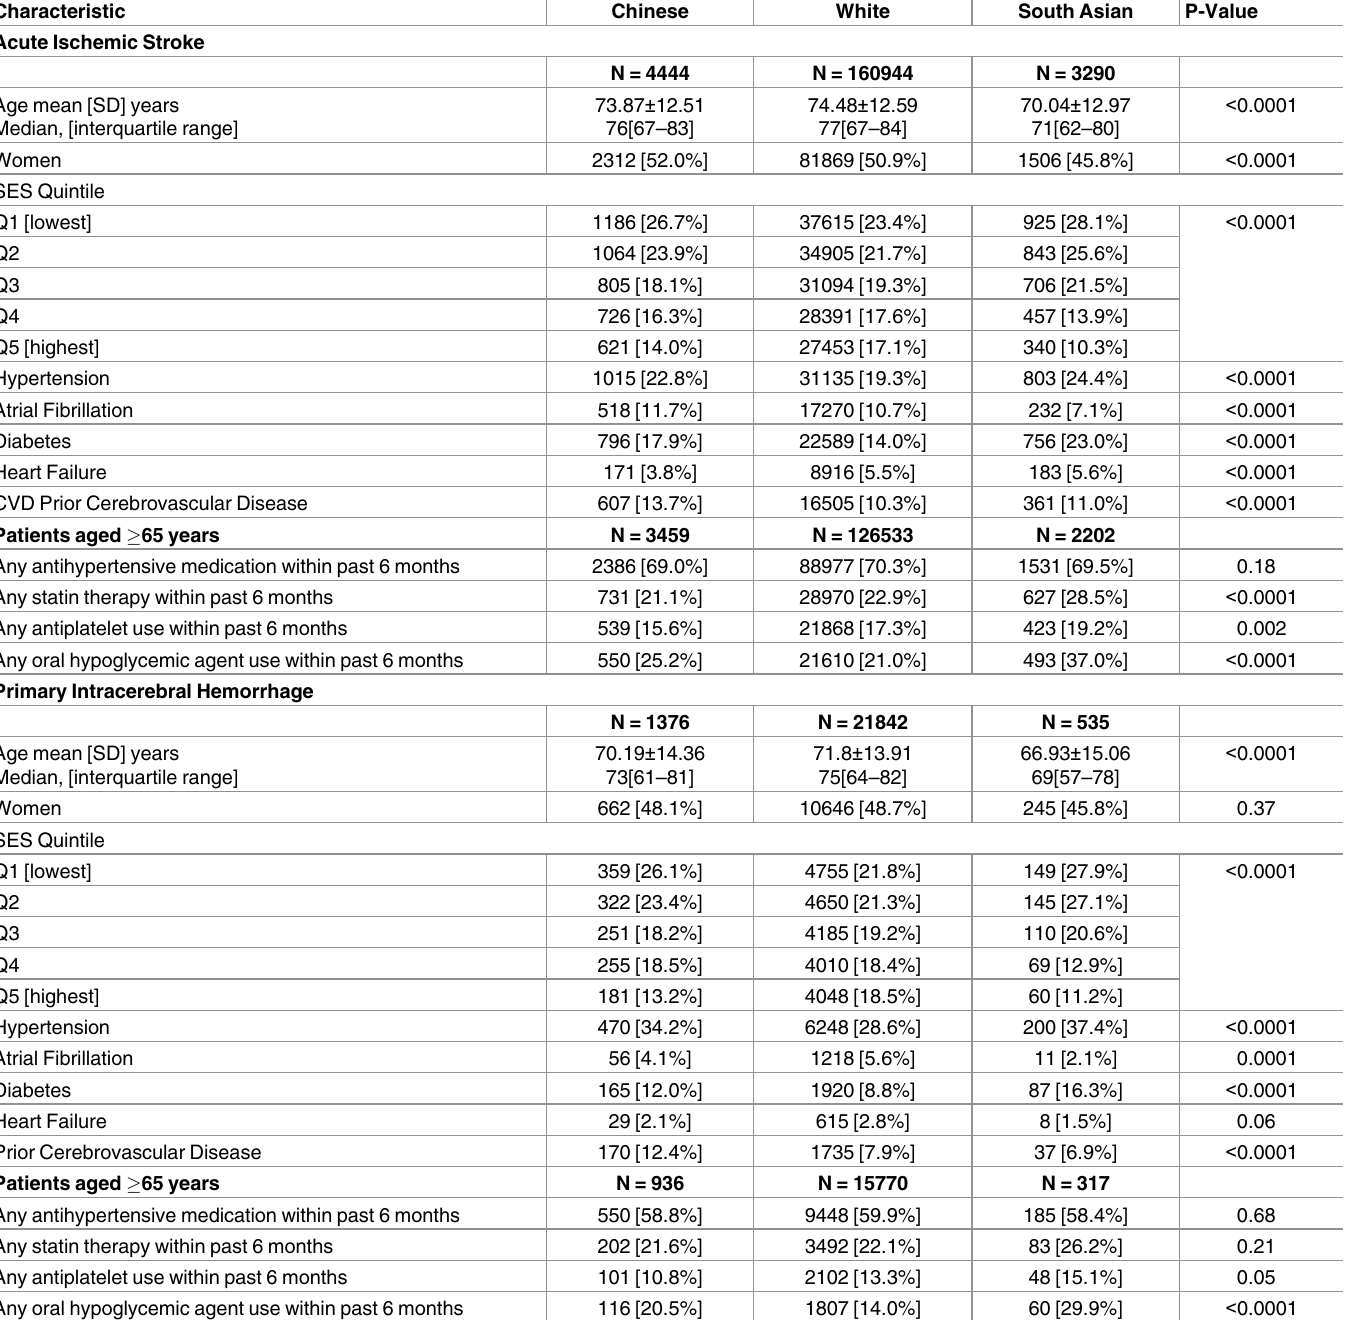
Table 1. Baseline characteristics by